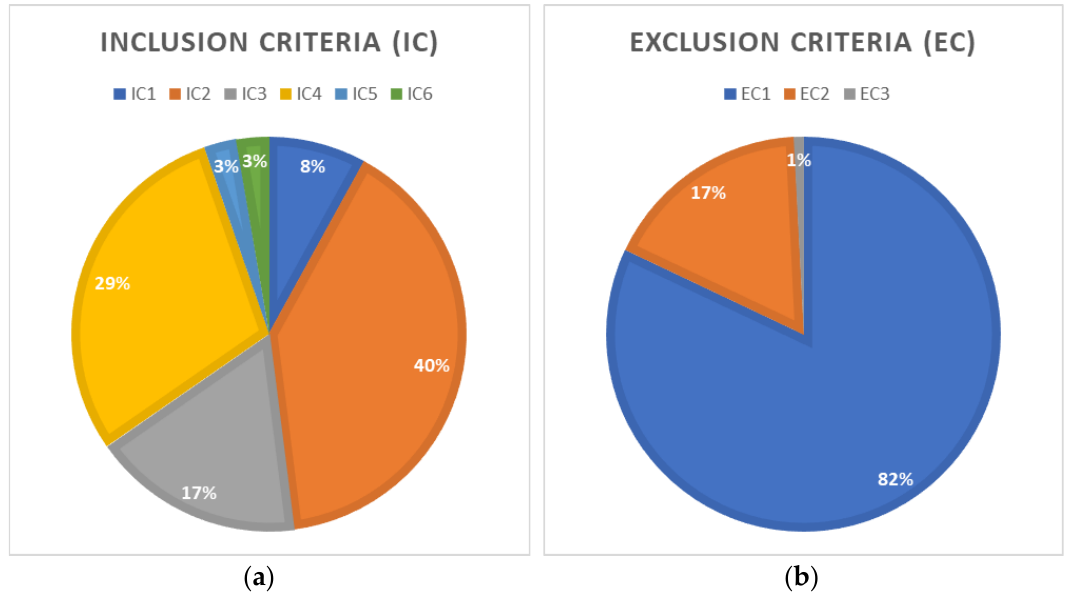
Figure 3. Publication ratio using: ( a ). inclusion criteria ( b ). exclusion